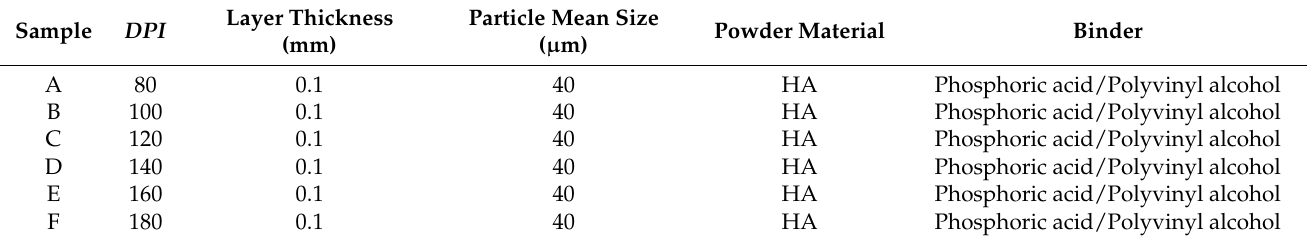
Table 2. 3D printing